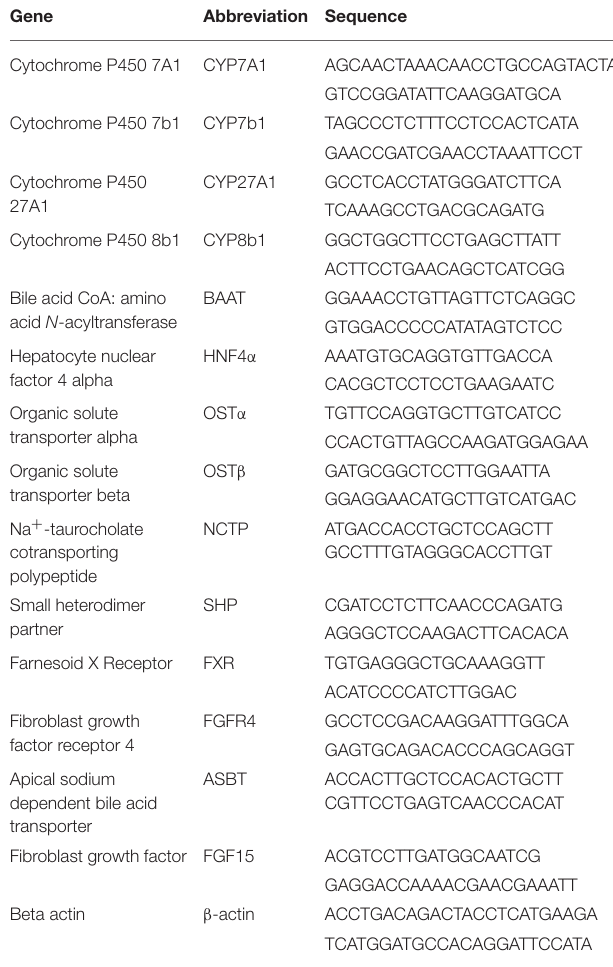
TABLE 1 | Primer sets for quantitative RT-PCR analysis of mouse